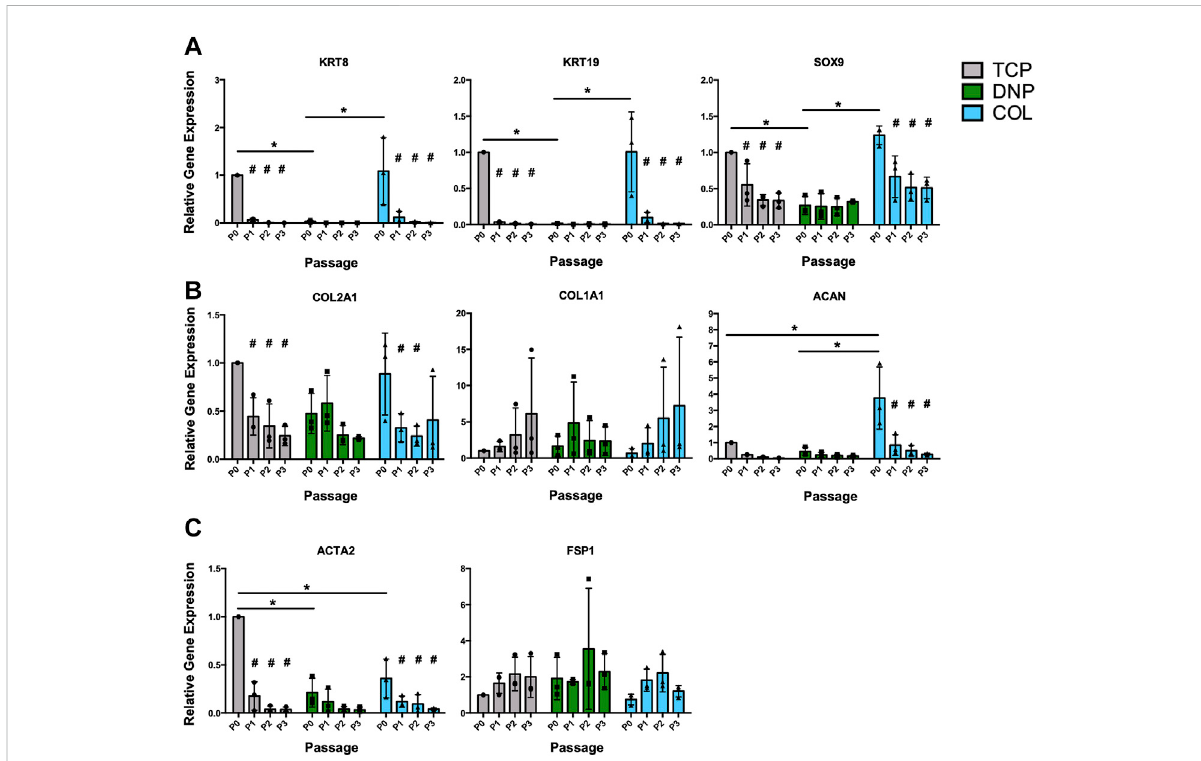
FIGURE 4 RT-qPCR gene expression analysis of serially passaged primary bovine NP cells grown in monolayer on tissue culture plastic or ECM coatings. Primary bovine NP cells (P0) were cultured in monolayer on tissue culture plastic (TCP), decellularized NP (DNP) coatings, or type I collagen (COL) coatings and serially passaged (P1-P3) on the same culture substrate. Gene expression analysis was performed to quantify expression of (A) NP- associated markers ( KRT8, KRT19, SOX9 ), (B) ECM genes ( COL2A1, COL1A1, ACAN ), and (C) fi broblast markers ( ACTA2, FSP1 ). Relative gene expression was determined using the ΔΔ C t method normalized to expression of the housekeeping gene GAPDH , and expressed relative to P0 cells on TCP. Data is presented as mean ± SD (N = 3, p < 0.05, * indicates signi fi cant differences between culture conditions, # indicates signi fi cant differences within each condition relative to P0